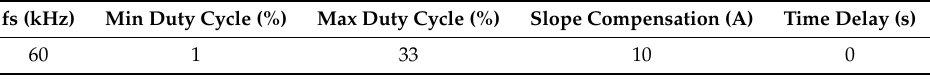
Table A2. LED Type D: Peak current control